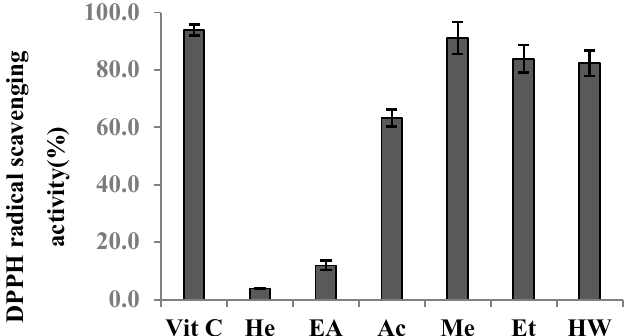
Figure 1. DPPH radical scavenging activity of various types of extracts from IW leaf (sample: 0.5 mg/mL, Asorbic acid: 25 μ g/mL). He: hexane ex, EA: ethylacetate ex, Ac: acetone ex, Me: methanol ex, Et: ethanol ex, HW: hot water ex.